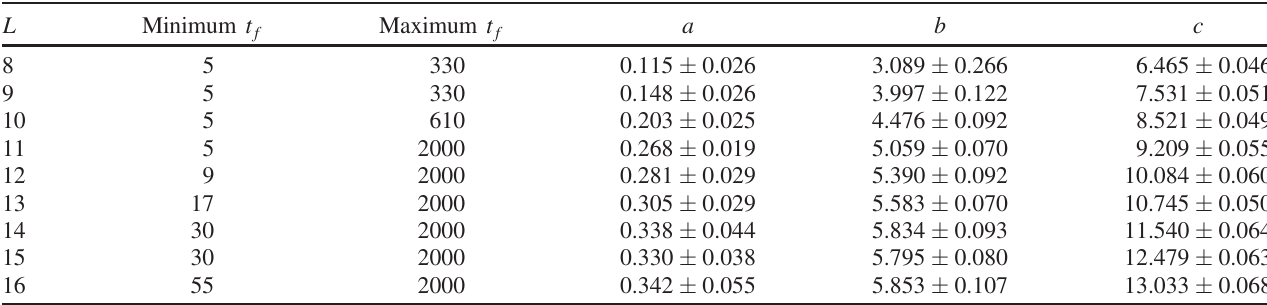
TABLE IX. Fit to y ¼ a ð x − b Þ 2 þ c for the median results of the hardware-planted instances using the DW2KQ with y ¼ log TTS and x ¼ log t f